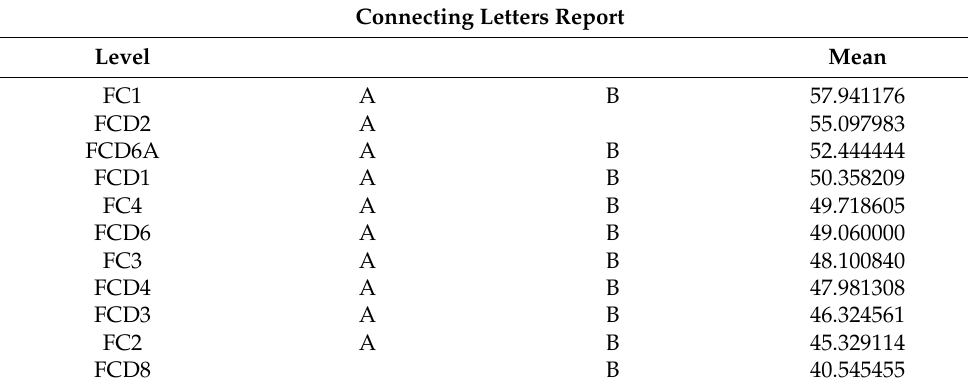
Table 4. LSD analysis of transportation time versus 11